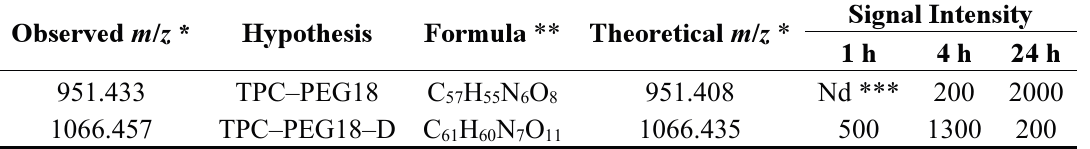
Table 5. Mass spectrometry (MS) peaks related to the hydrolysis of TPC–PEG18–DKPPR observed in the liver after 1, 4 and 24 h and their hypothesis of structure (See Figure S4 in “Supplementary